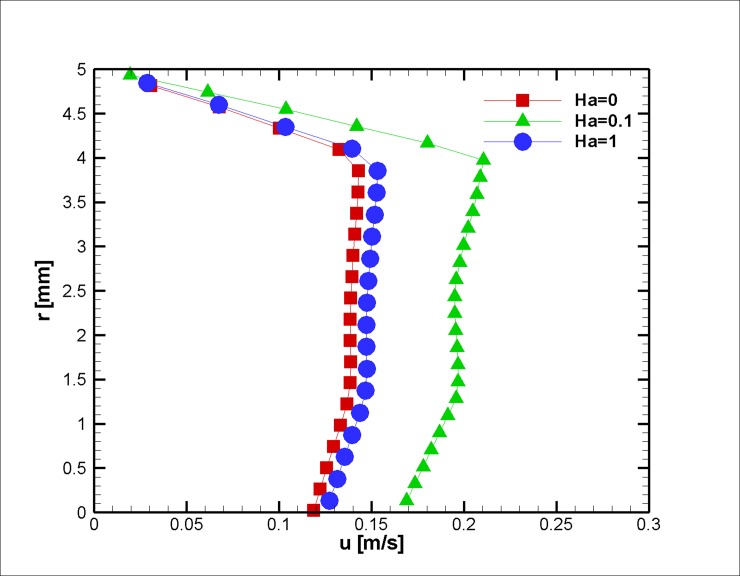
Velocity in the axial direction distribution for three different Ha Numbers at z = 2 cm and t = 0.75 s, Lvessel = 7 cm, Rvessel = 1 cm and fifty percent stenosis.